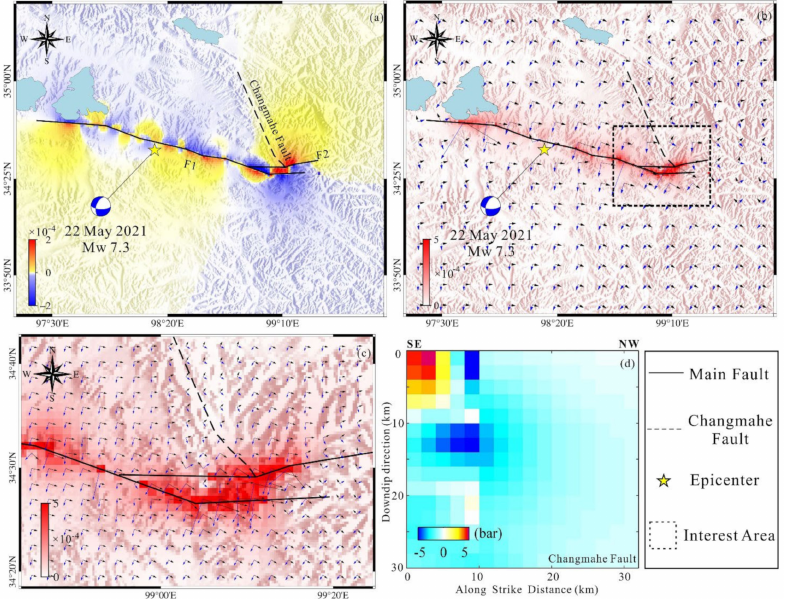
Figure 12. Strain and Coulomb failure stress change caused by the rupture of the main faults (F1 and F2). ( a ) Surface dilatation due to the faulting of the main faults, and positive and negative values indicate surface extension and compression, respectively. ( b ) The maximum shear strain change caused by the rupture of the main faults, and the blue and black arrows indicate the direction of the maximum shear strain change. ( c ) Maximum shear strain change within the black dashed rectangle in Figure 12b. ( d ) Coulomb failure stress change on the Changmahe fault (F3) caused by the rupture of the main faults (F1 and F2). The black solid lines indicate the surface trace of the two main faults, F1 and F2, the black dashed line denotes the Changmahe fault, and the yellow star indicates the epicenter of the 2021 Maduo Mw 7.3